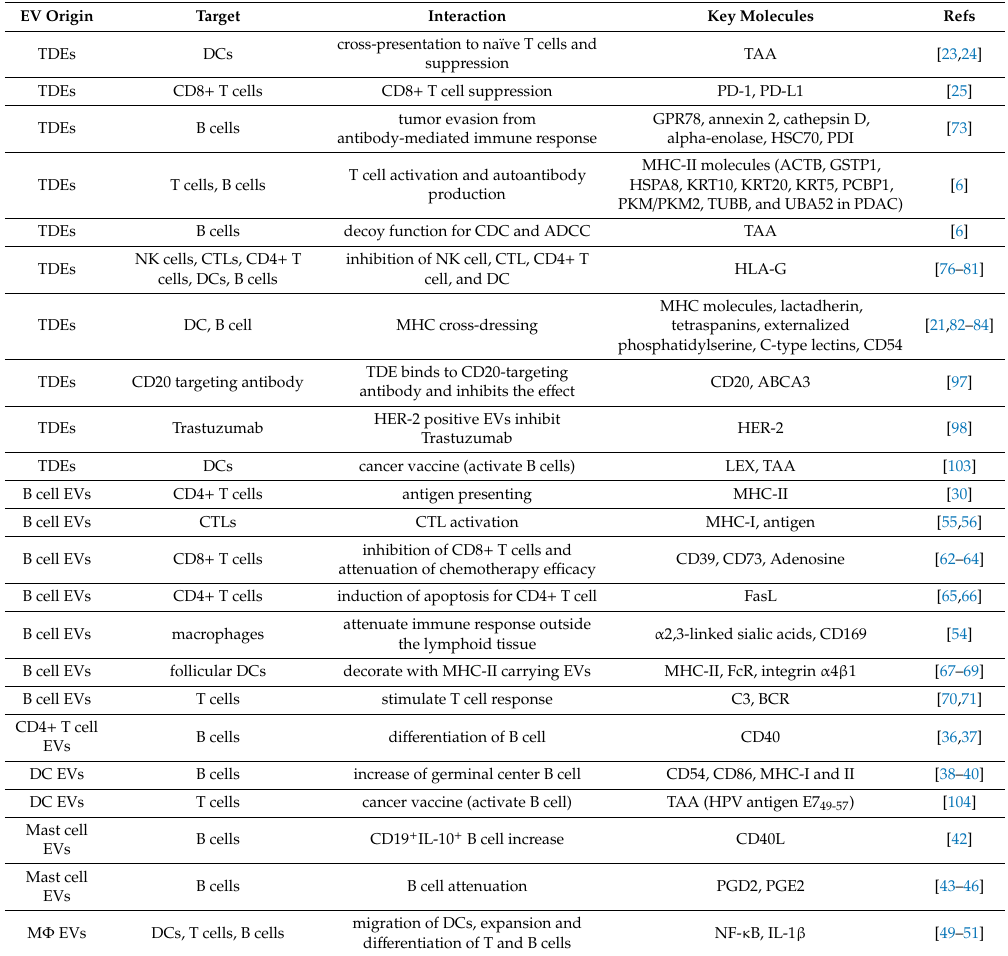
Table 1. Tumor- and immune-cell-derived extracellular vesicles (EVs) mediate multilateral networks of